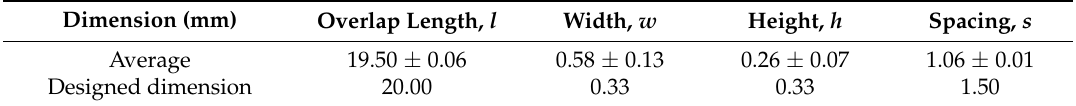
Table 1. The actual dimensions of the printed IDC, dimensions in mm.